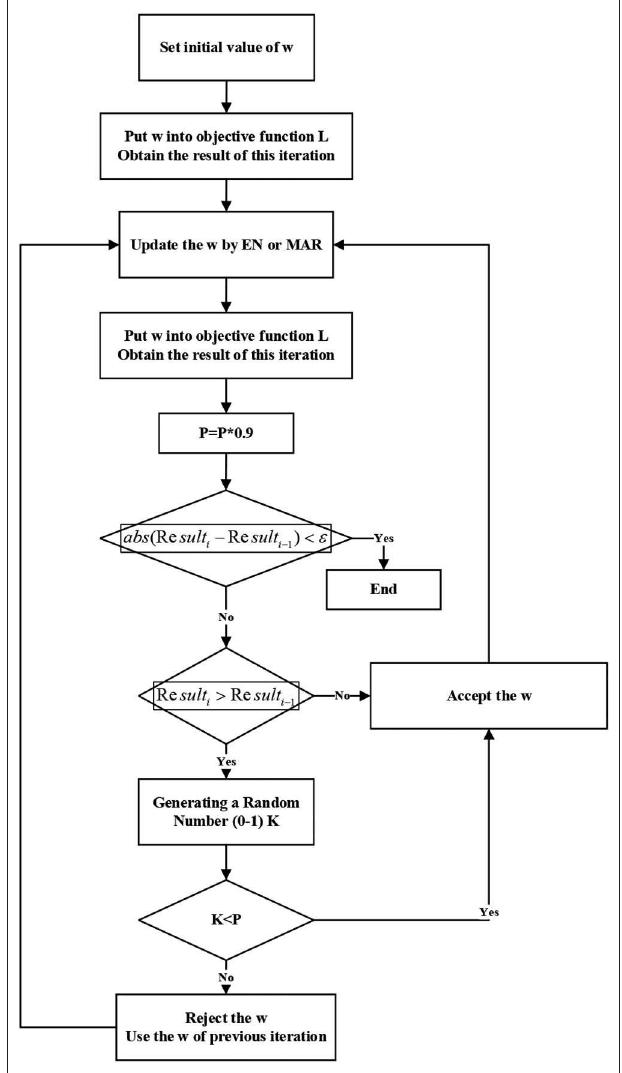
FIGURE 3 | Work flow of finding optimal solution.